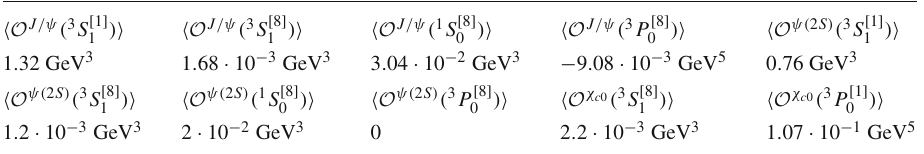
Table 4 The values of LDMEs we used from Ref. [67] and Ref.